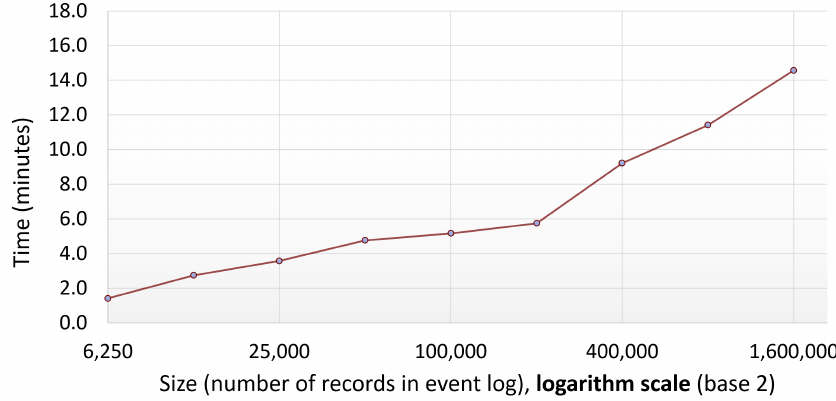
Figure 7. Script execution performance (the X axis uses a logarithmic